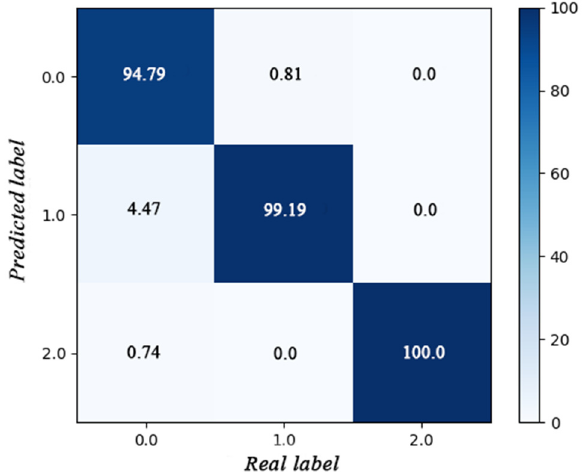
Figure 8. Confusion matrix for the model results on the test set.